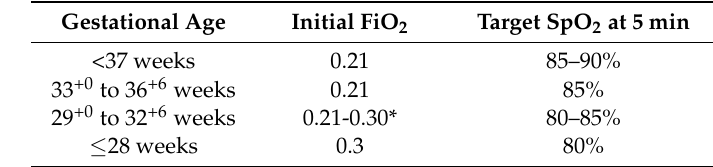
Table 1. Suggestions on how to supply oxygen in the delivery room to newly born